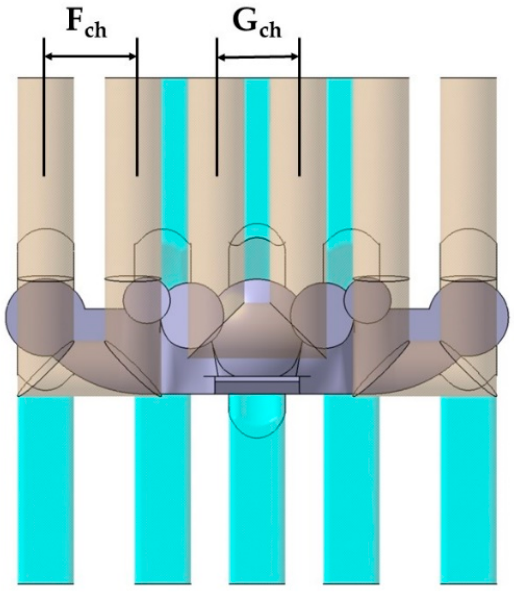
Figure 11. V ch parameter.